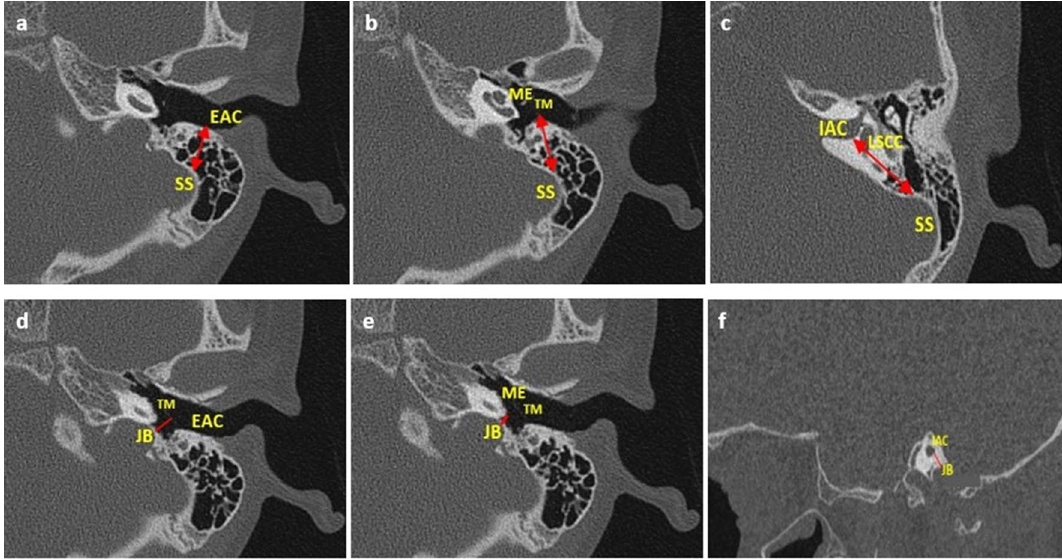
Figure 1. Diagrammatic representation of all measurements. SS sigmoid sinus, JB jugular bulb, EAC internal acoustic canal, ME middle-ear, IAC internal acoustic canal, TM tympanic membrane, LSCC lateral semicircular canal . ( a ) SS – EAC (on the axial plane, a double-tipped red arrow from the apex of SS to the posterior wall of EAC); ( b ) SS – ME (on the axial plane, a double-tipped red arrow from the anterior edge of SS to the tympanic membrane); ( c ) SS – IAC (on the axial plane, a double-tipped red arrow from the anterior edge of SS to the posterior wall of IAC); ( d ) JB – EAC; (on the axial plane, a red line from JB to the tympanic border); ( e ) JB – ME (on the axial plane, a red line from JB to the sigmoid plate); ( f ) JB – IAC (on the sagittal plane a red line from the dome of JB to the inner